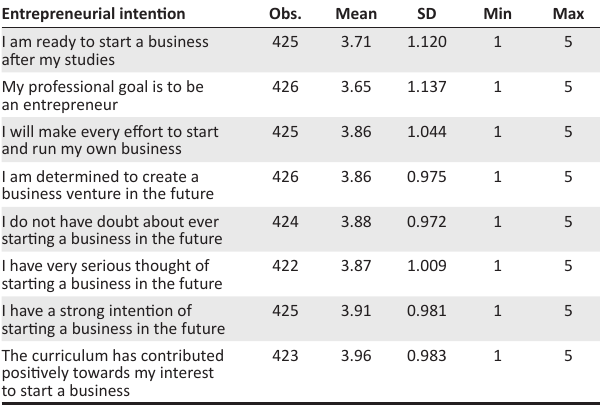
TABLE 8: Entrepreneurial intention.